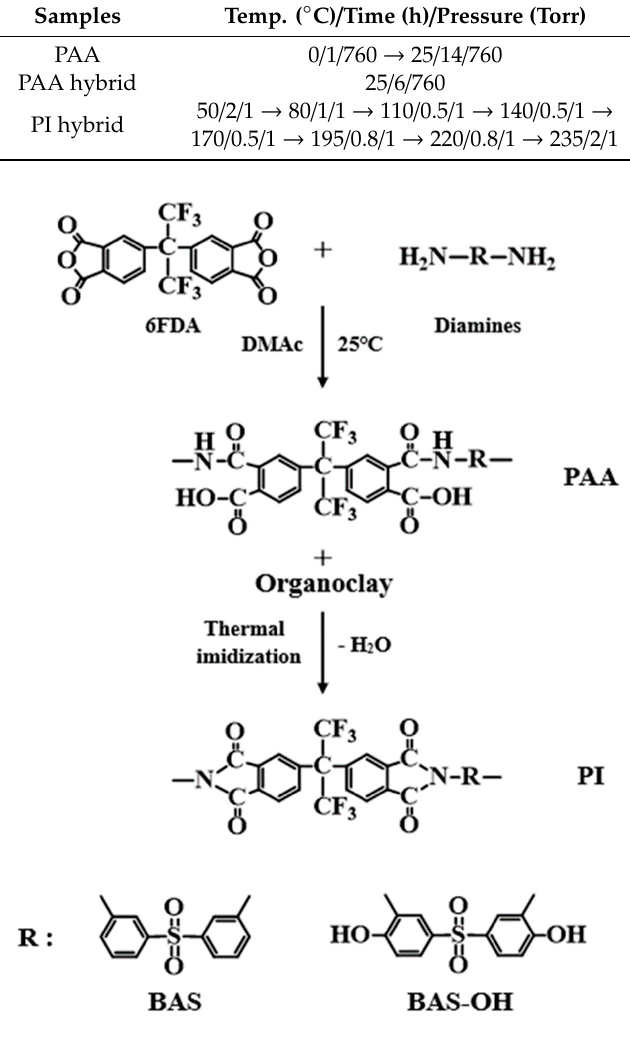
Figure 1. Synthetic route of PI hybrids with various diamines.